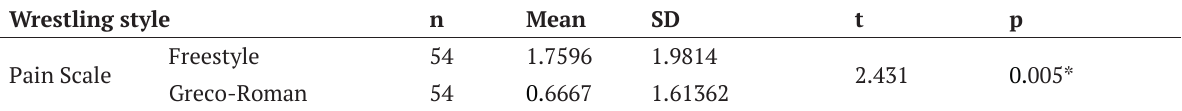
Table 10. Pain scale analysis results of the study group according to the wrestling style